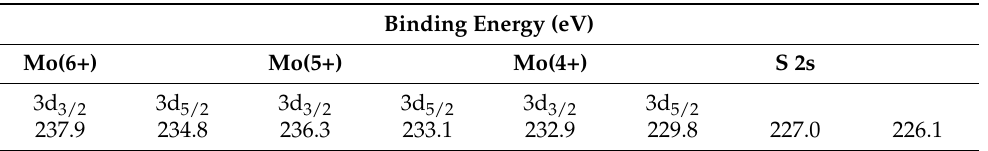
Table 2. Binding energy values of Mo 3d and S 2s peaks in accordance with the deconvolution of XPS spectrum, as shown in Figure 2j.